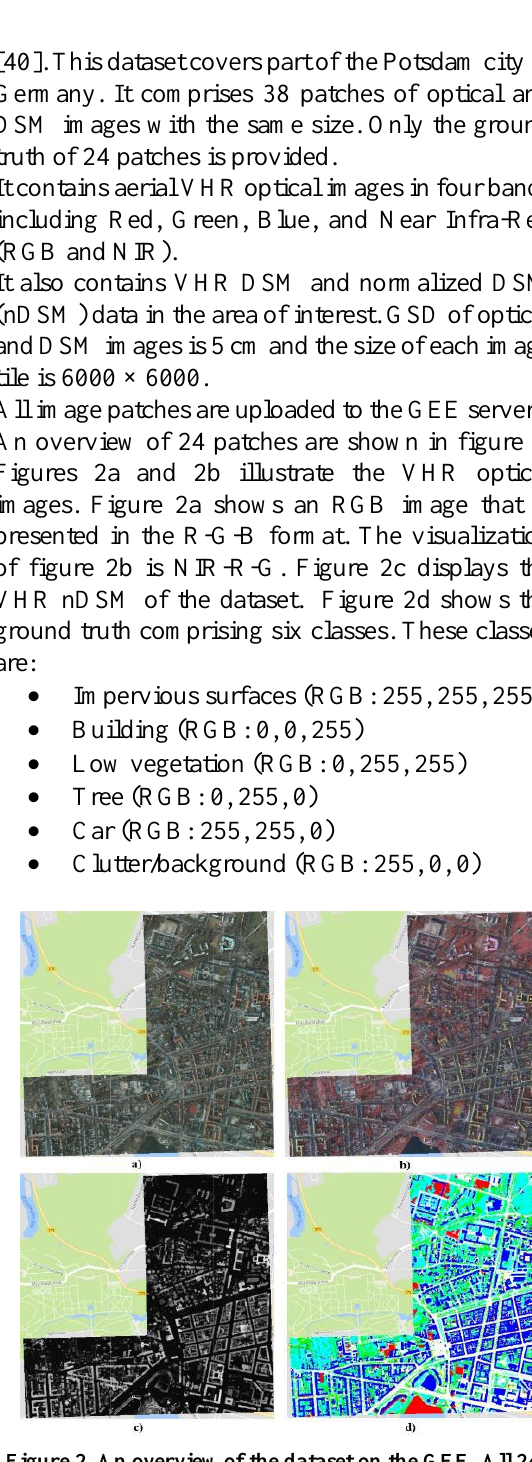
Figure 2. An overview of the dataset on the GEE. All 24 patches are shown. (a) RGB image. (b) NIR-R-G image. (c) nDSM image. (d) Ground